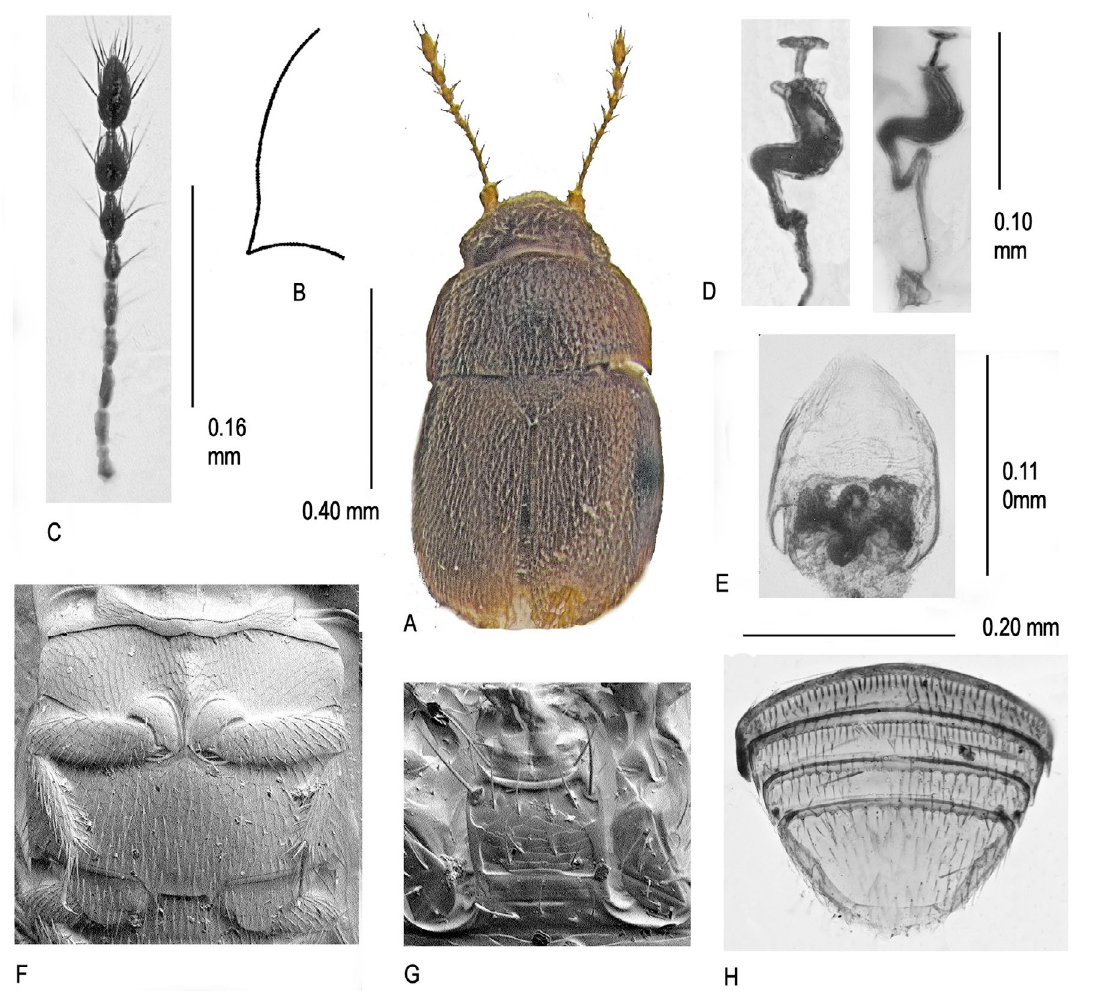
Fig. 20. Acrotrichis hanskii sp. nov. A . Habitus. B . Hind angle of pronotum viewed at 45°. C . Antennomeres III–XI. D . Spermatheca. E . Aedeagus. F . Meso- and metaventra ×425. G . Mentum and submentum ×1600. H .